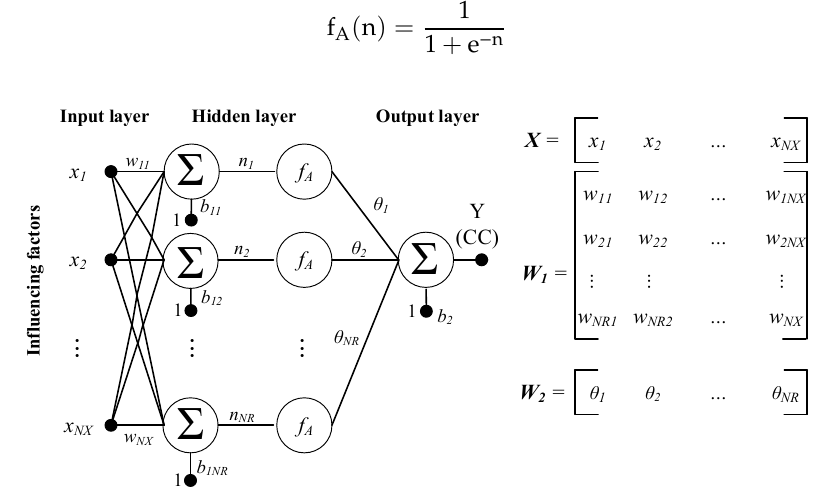
Figure 1. A typical structure of the neural network.